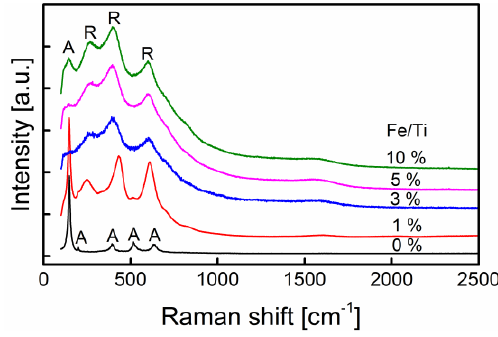
Figure 2. Raman spectra for Fe-doped TiO 2 nanoparticles prepared by FSP with various Fe ratios (A, anatase. R, rutile).